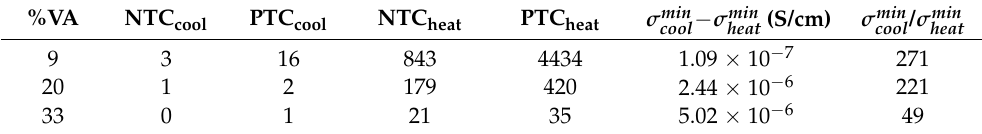
Table 7. Temperature coefficients for the different EVAs at 4.5 vol% GNP